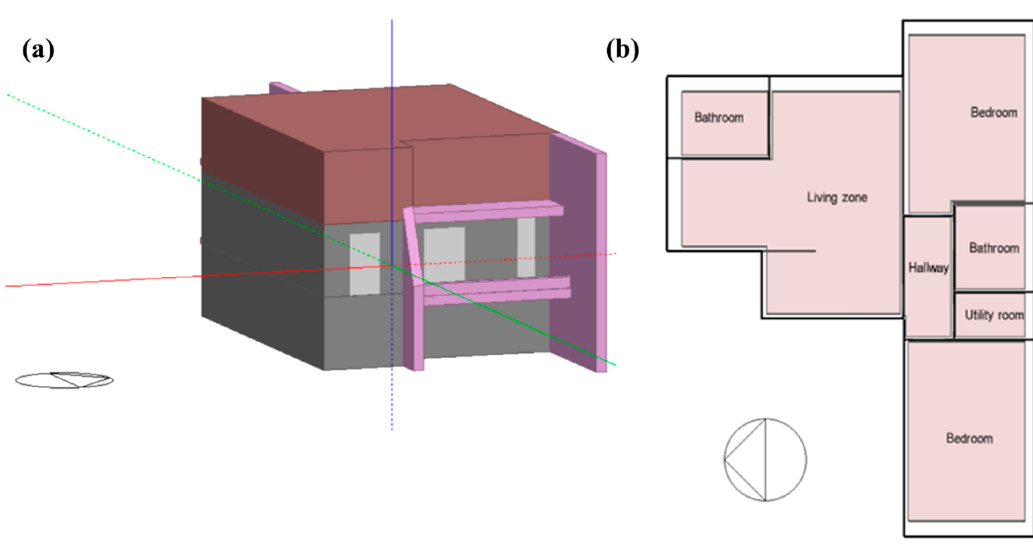
Figure 3. The model of the residential unit: ( a ) DesignBuilder model of the building; ( b ) plan of the apartment.